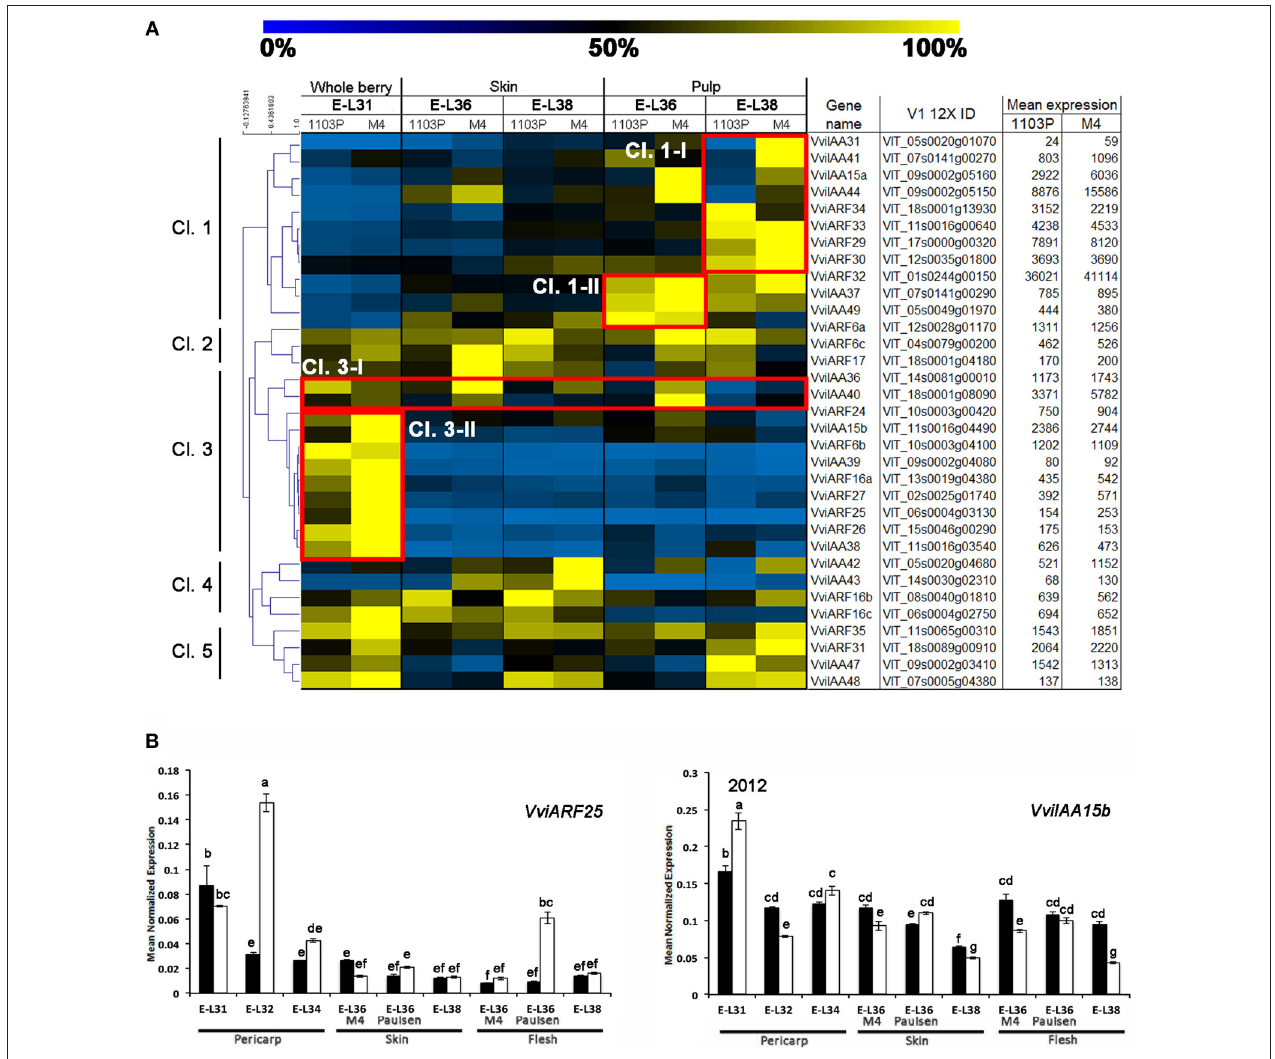
FIGURE 4 | (A) Heat-map showing the expression of auxin-related VvARF and VvAux/IAA genes based mRNA-Seq data. The expression values were calculated as a percentage related to the developmental stage showing the highest expression value (100 and 0% for yellow and blue colors, respectively) within all mRNA-seq datasets considered (E-L31, E-L36, and E-L38). Proposed gene name ( Supplementary Results S1 ), PN40024V1 12X identifier, and mean of normalized counts are also reported. (B) quantitative RT-PCR analyses on two genes belonging to Cl.3-II ( VviARF25 and VviIAA15b ) in flesh and skin of berries sampled from both 1103P/CS (solid bars) and M4/CS (empty bars) graft combination in 2012 growing season Results are shown as means and SE for three biological replicates. Bars indicate SE. Different letters indicate statistically significant differences ( P = 0.05 ) by Duncan’s new multiple range